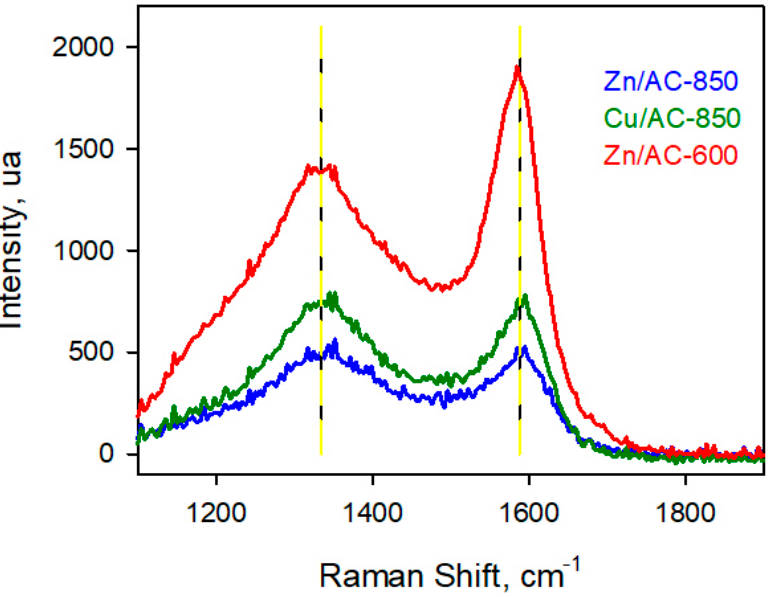
Figure 6. Raman spectra of Zn/AC-850, Zn/AC-600 and Cu/AC-850.